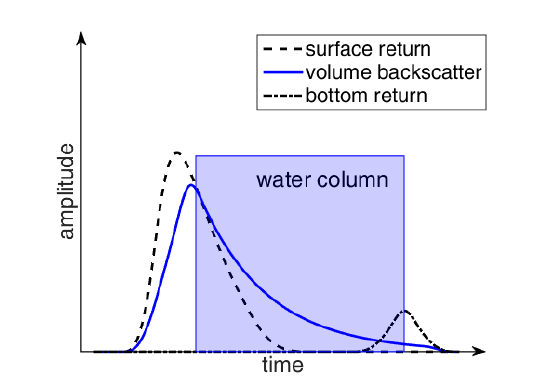
Figure 1: Waveform of a prototype ALB laser pulse echo (Richter et al.,